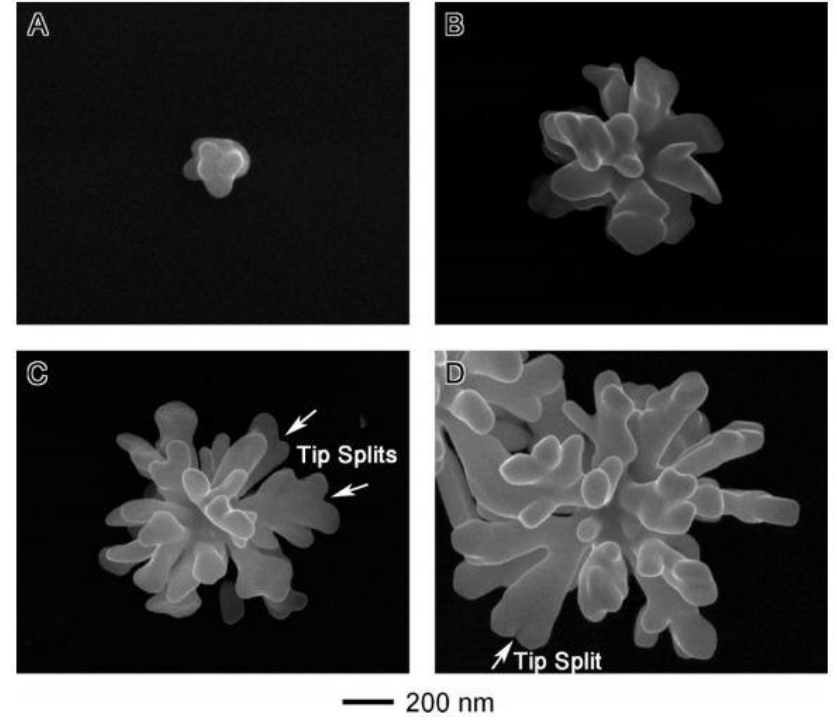
Figure 5. SEM images of the silver particles sampled at different reaction times ( A ) 3–8 s; ( B ) 20–30 s; ( C ) 1 min; and ( D ) 5 min. Arrows indicate examples of tip splits (reprinted with permission from [52]. Copyright (2008) American Chemical Society).